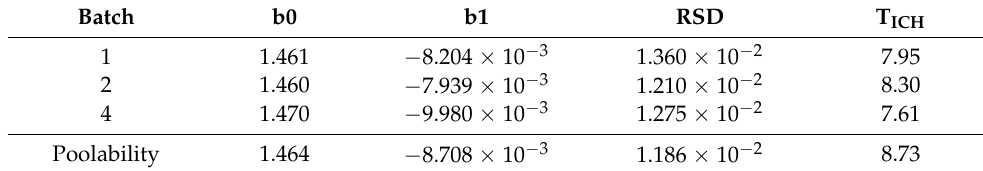
Table 4. Results of stability study by individual and poolability batches (T ICH in months).